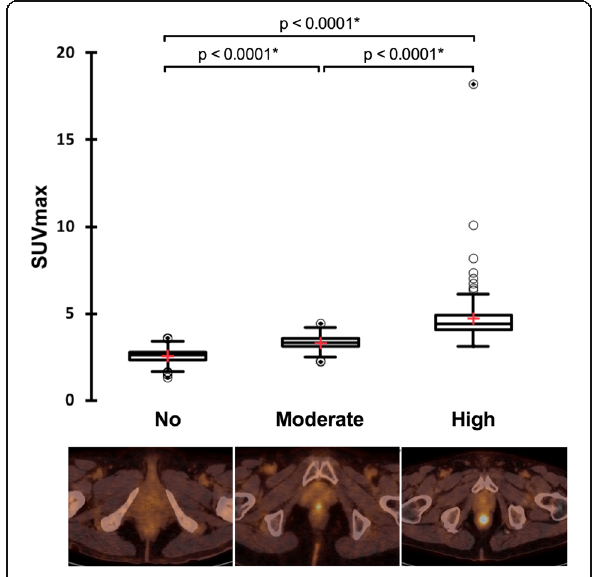
Fig. 2 Visual versus quantitative analysis of anal canal uptake. Data are presented as Tukey ’ s boxplots and o represents outliers